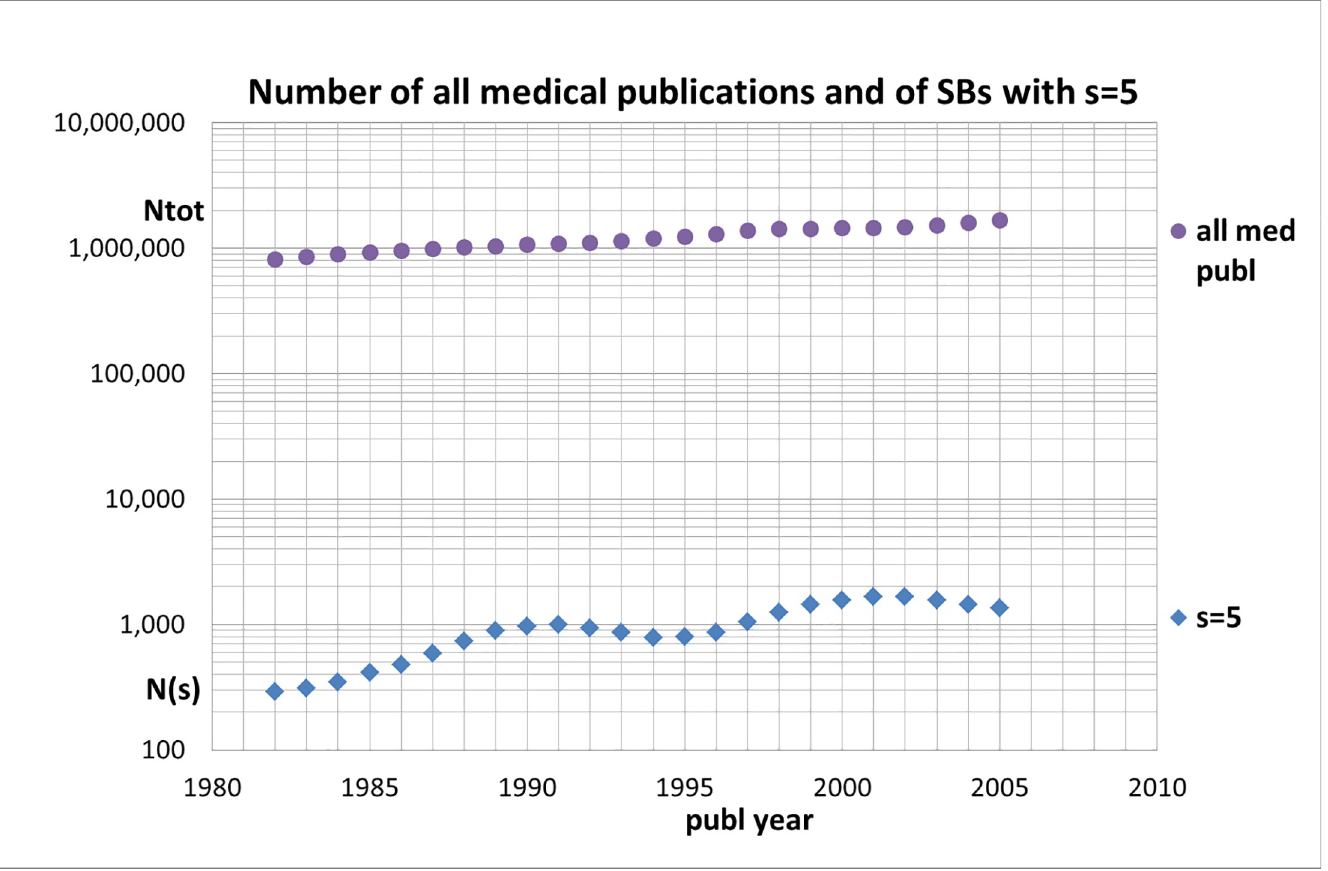
Fig 2. Trend of the number (real, i.e. not-normalized) of all medical publications (N tot ), and the number N(s) of SBs with sleeping time s = 5; numbers are the totals of successive five-years blocks, each five-years block is located in the figure by its middle